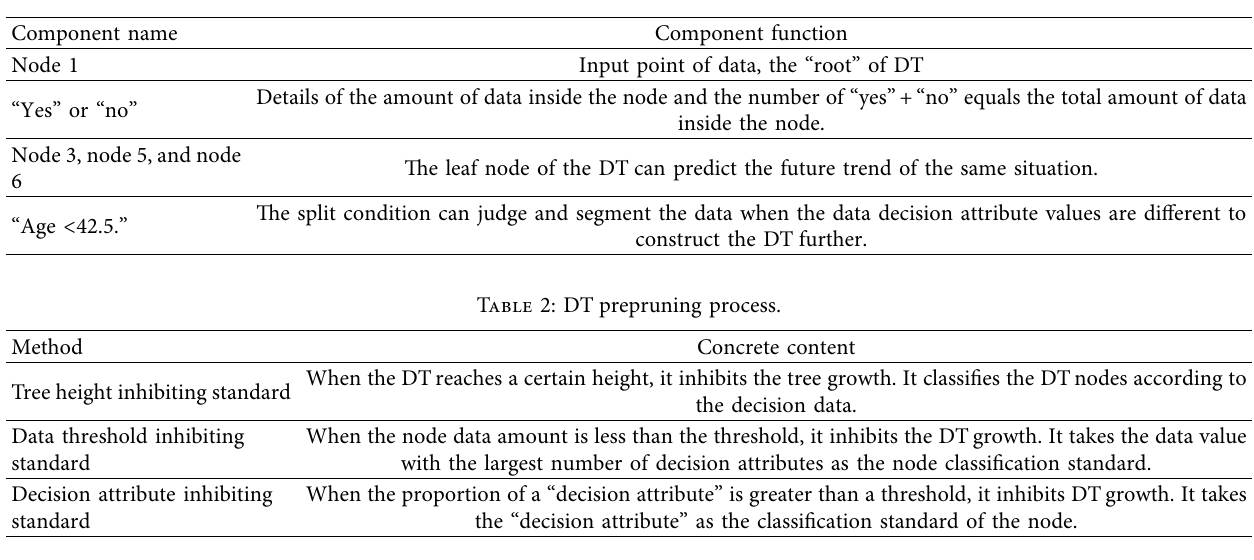
Figure 4: Basic structure diagram of DT. Table 1: Basic structure of DT.